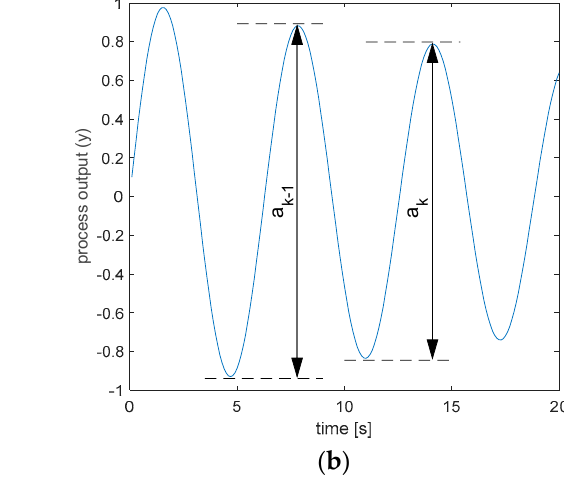
Figure 4. Amplitudes of the previous cycle ( a k − 1 ) and the present cycle ( a k ) : ( a ) divergence pattern; ( b ) convergence pattern.